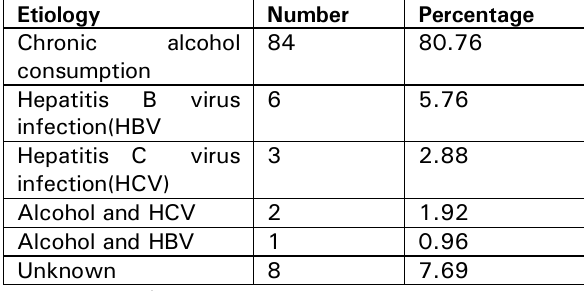
Table 4: Etiology of